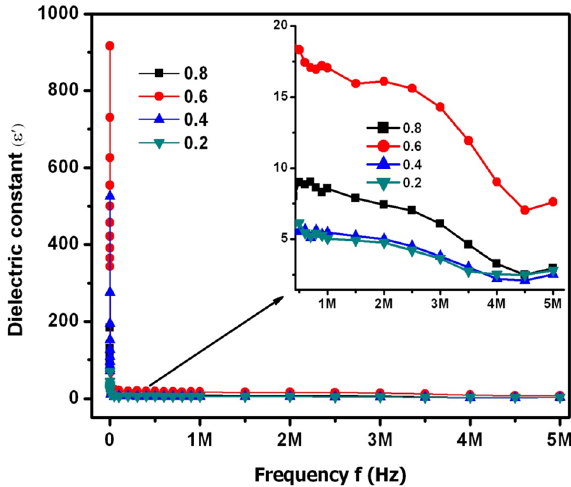
Figure 12. ε ′ −f plots of SLFO nanoparticles.